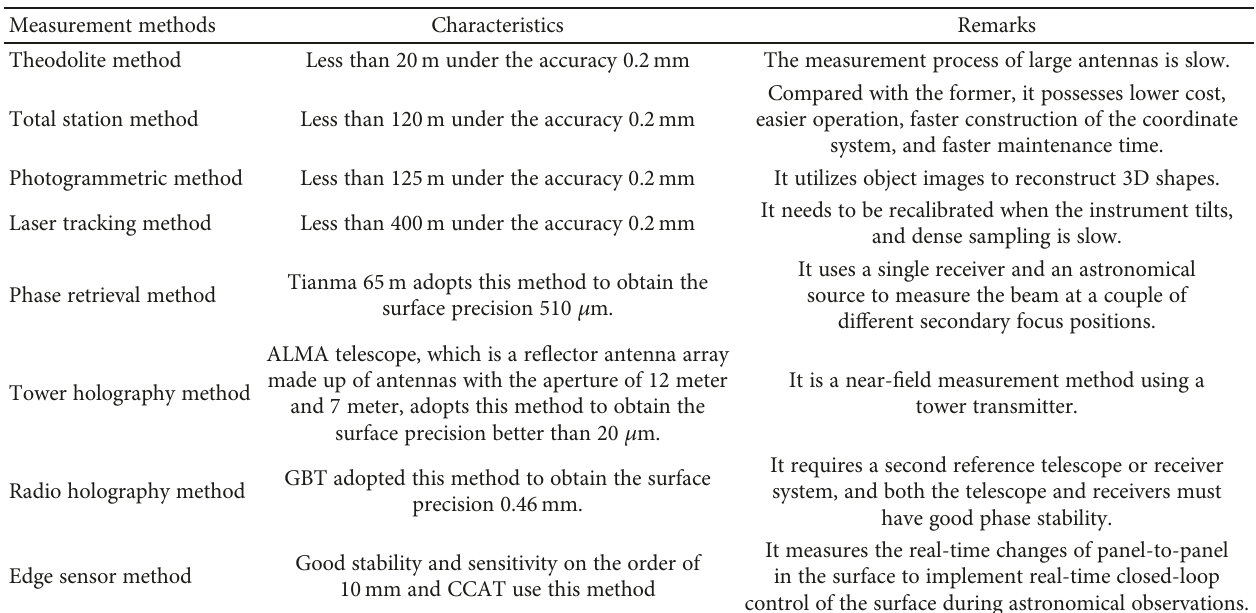
Table 2: Modern antenna surface measurement